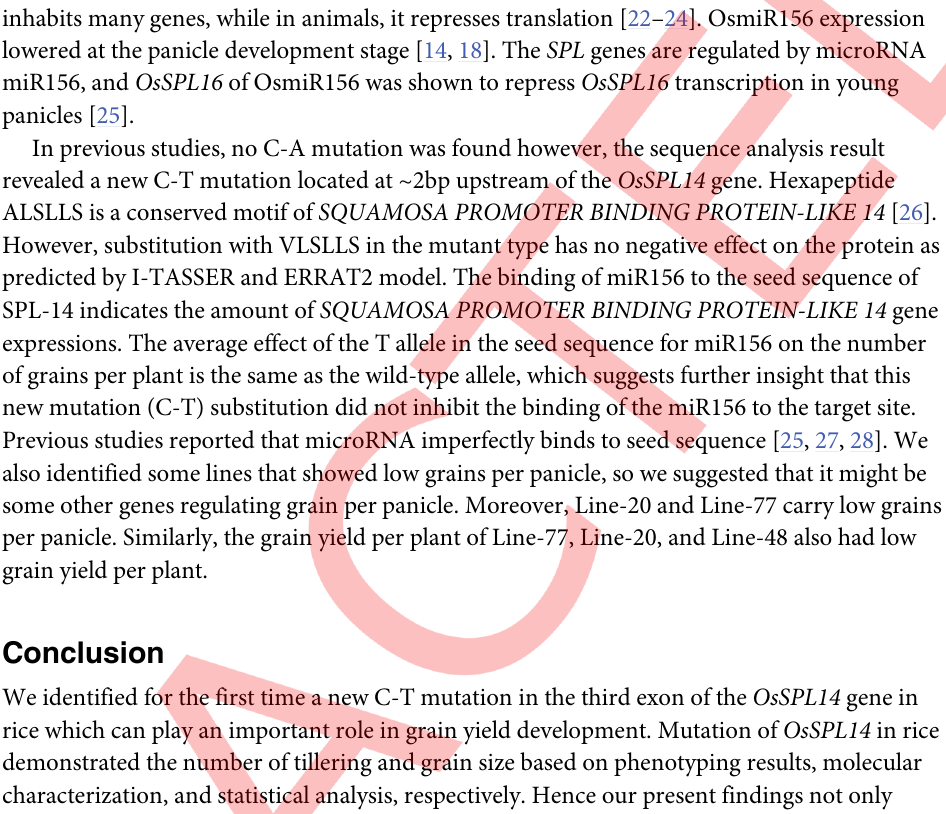
S1 Table. List of selected genotypes. S2 Table. Allele specific molecular marker used in the